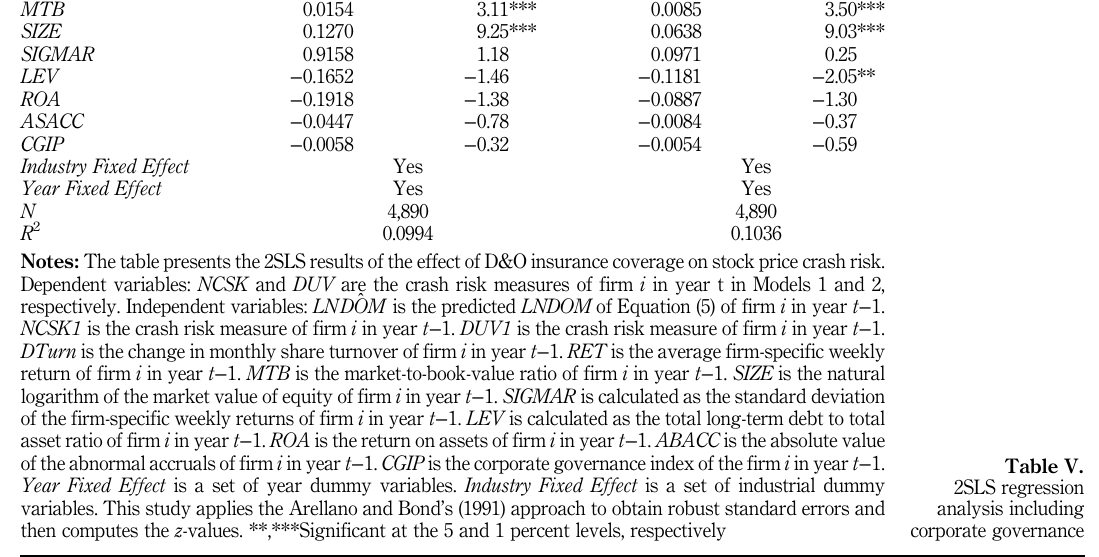
Table V. 2SLS regression analysis including corporate